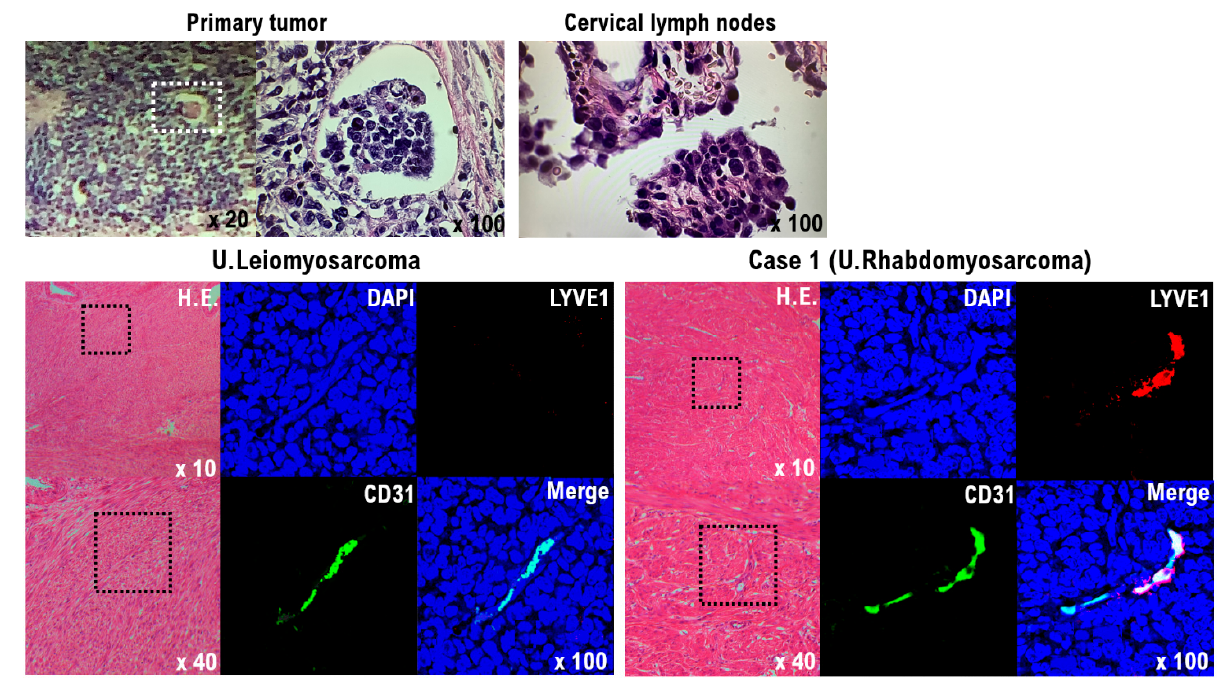
Figure 4. Significance of lymphatic endothelial cells in the primary Case 1 uterine tumor. Tumor cells infiltrating the lymph vessels within the uterine tumor are round cells with a high nuclear cytoplasmic ratio (N/C) (upper left panel). Circular cells with a high nuclear cytoplasm ratio (N/C) were also found in the biopsy from the tumor of the left supraclavicular lymph node (upper right panel). The results indicate that tumor cells from the primary uterine tumor formed metastases in the left supraclavicular lymph node by lymphatic metastasis. H&E staining and immunofluorescence of uterine leiomyosarcoma and the Case 1 uterine tumor with an anti-human CD31 (green) and anti-human LYVE-1 antibody (red) (lower panels). Human vascular endothelial cells and lymphatic endothelial cells were detected as CD31 and LYVE-1 double-positive cells. The tumor cells from the Case 1 uterine tumor appear to differentiate into lymphatic endothelial cell progenitors (lower light panel), but the tumor cells from the uterine leiomyosarcoma do not appear to have differentiated to lymphatic endothelial cell progenitors (lower left panel).